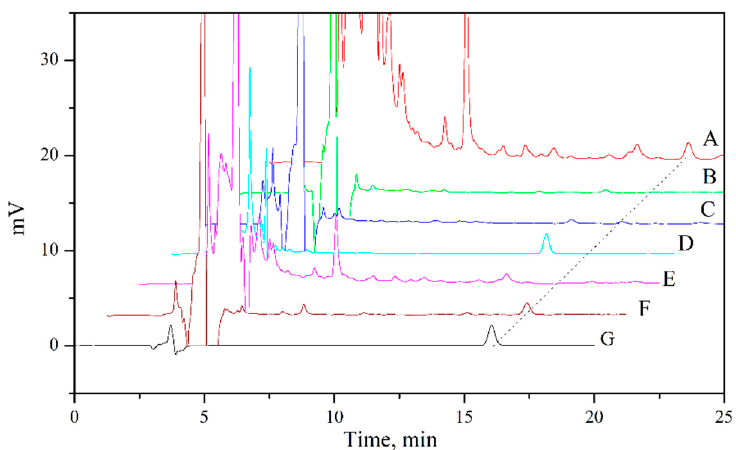
Figure 6. Chromatograms. ( A ) extracted solution, ( B ) solution after loading, ( C ) washing using hexane, ( D ) washing using water, ( E ) washing using methanol, ( F ) elution using methanol/0.10 M NaOH (90.00:10.00, v/v), ( G ) standard solution.